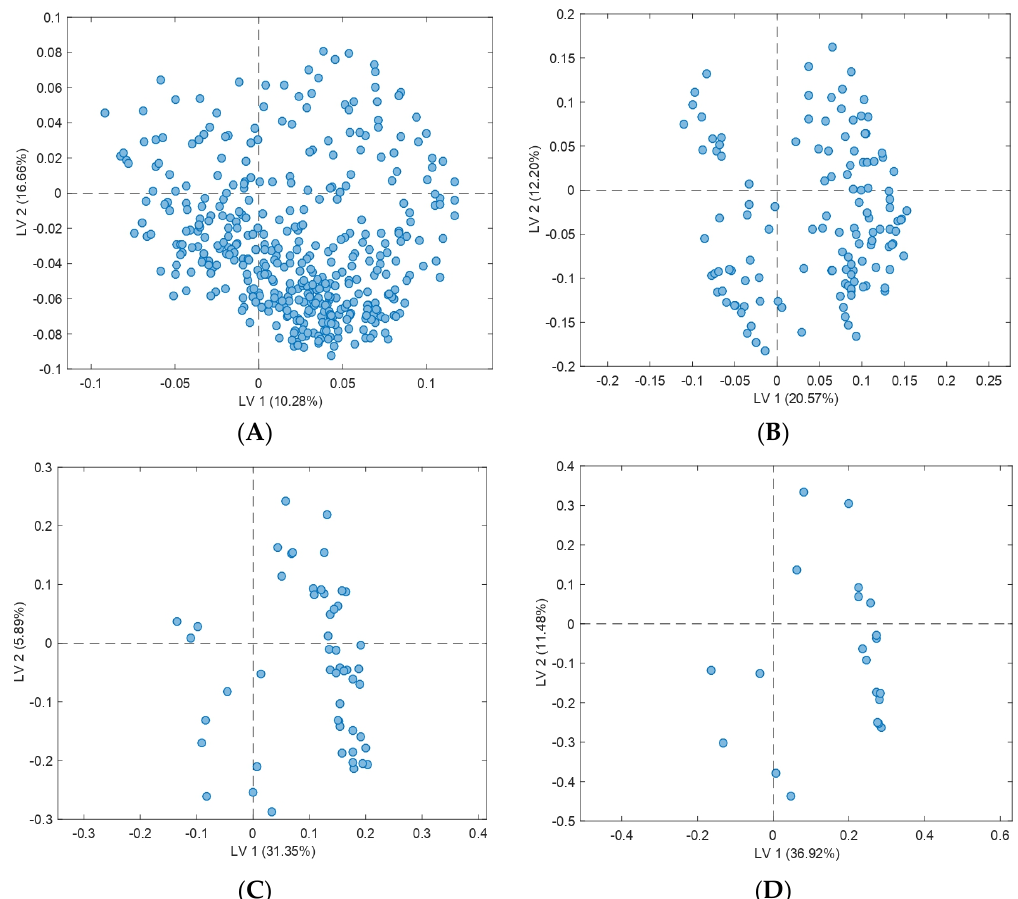
Figure 4. Loading plots obtained for consecutive PLS-DA models performed through the reduction of the initial 409 features in the targeted approach (Model 2) (from 4A, performed with all the 409 initial features, to 4D, performed only with the 21 final features).